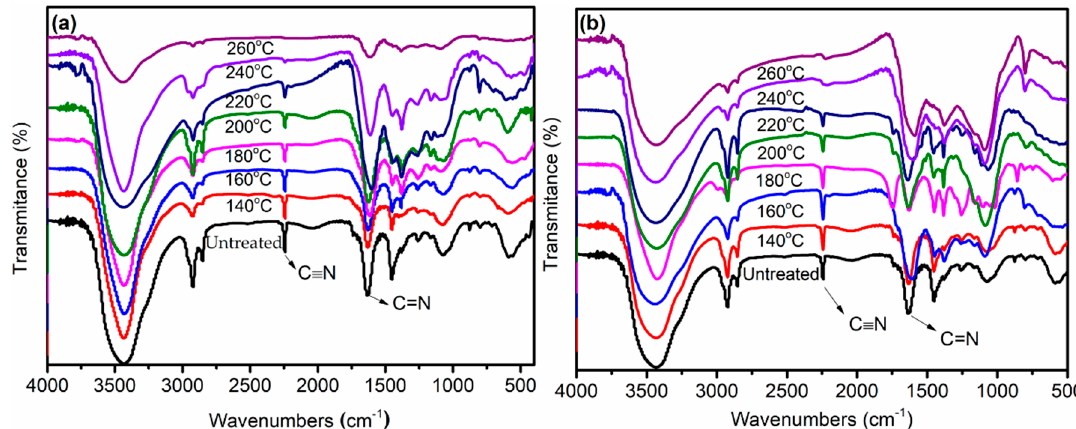
Figure 2. Fourier transform infrared spectra (FT-IR) spectra of PAN fibers treated at different temperatures: ( a ) in Sc-CO 2 ; ( b ) in air.